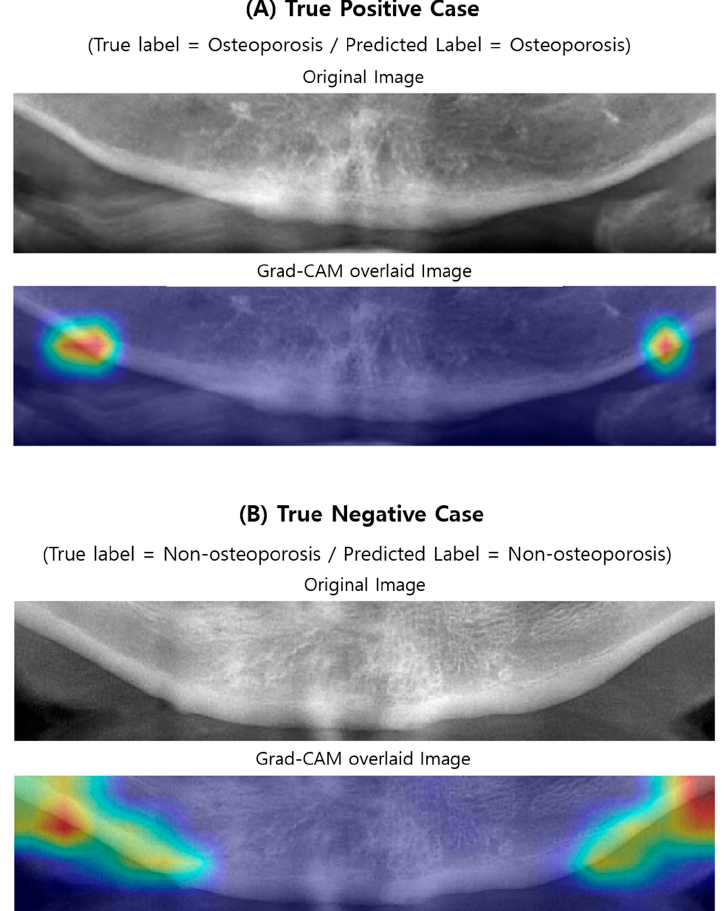
Figure 5. Original and Grad-CAM sample images of correctly predicted by the best-performing deep CNN model (VGG16-TR-TF) for DPR image-based osteoporosis screening are illustrated. Below each original sample images, a Grad-CAM image is superimposed over the original image. The bright red in